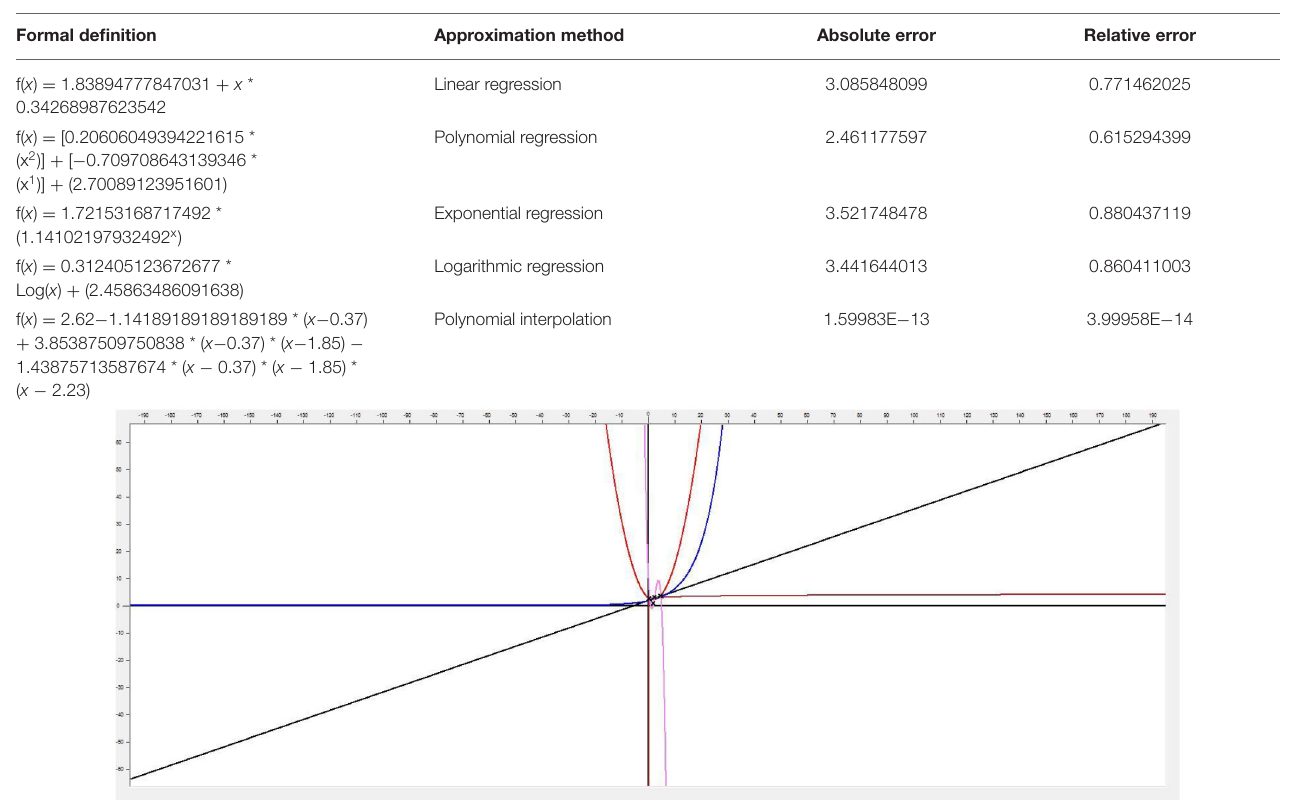
TABLE 6 | Function estimation quadrant I: focus behavior